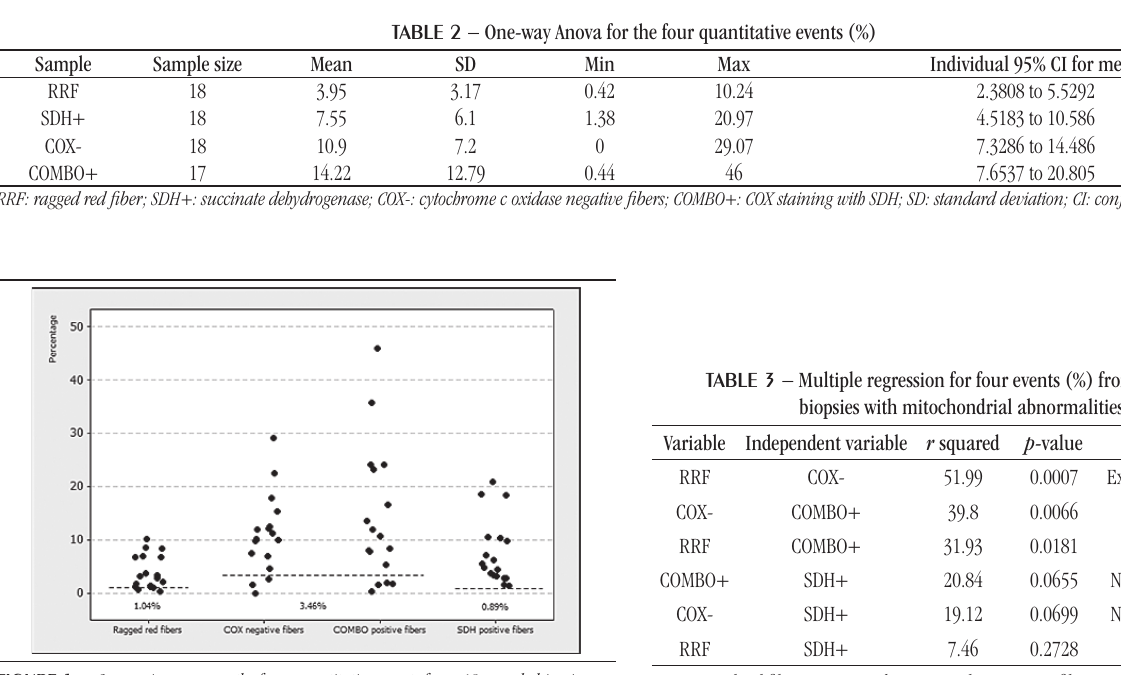
figurE 1 − Comparison among the four quantitative events from 18 muscle biopsies with mitochondrial abnormalities. Limit of normality from Sleigh et al. (2011)